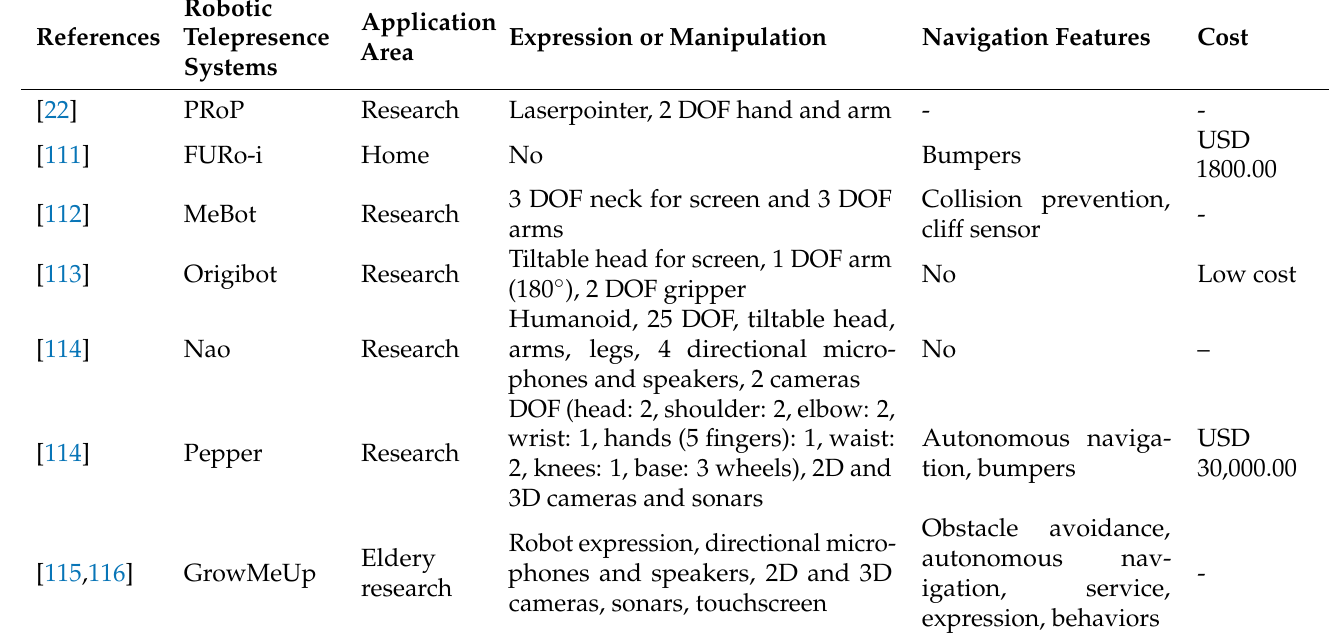
Table 5. Mobile robotic telepresence (MRP) systems: research-oriented solutions.